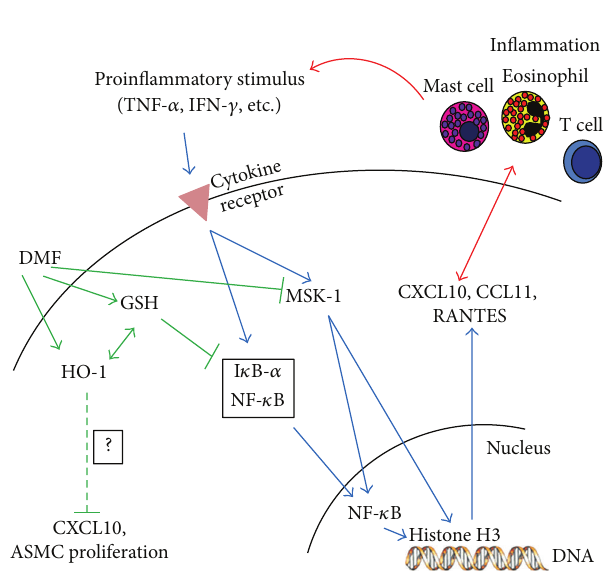
Figure 3: Secretion of chemokines such as CXCL10, CCL11, or RANTES by ASMC attracts immune cells (eosinophils, T cells, or mast cells) into the asthmatic airway. In turn, these immune cells secrete proinflammatory cytokines (TNF- 𝛼 , IFN- 𝛾 , etc.), which stimulate proinflammatory signaling molecules such as NF- 𝜅 B or MSK-1 in ASMC, enhancing its proinflammatory function. DMF reduces intracellular reduced glutathione (GSH) level and thereby induces HO-1 expression and I 𝜅 B-glutathionylation. DMF-induced HO-1 decreased CXCL10 and ASMC proliferation by an unknown mechanism. I 𝜅 B-glutathionylation inhibited I 𝜅 B degradation and subsequent NF- 𝜅 B nuclear entry. Furthermore, DMF inhibited MSK-1-mediatedhistoneH3andNF- 𝜅 Bphosphorylation,leadingto reduced secretion of CXCL10, CCL11, and RANTES. DMF reduces ASMC chemokine secretion and may therefore inhibit the crosstalk between ASMC and immune cells, leading to airway